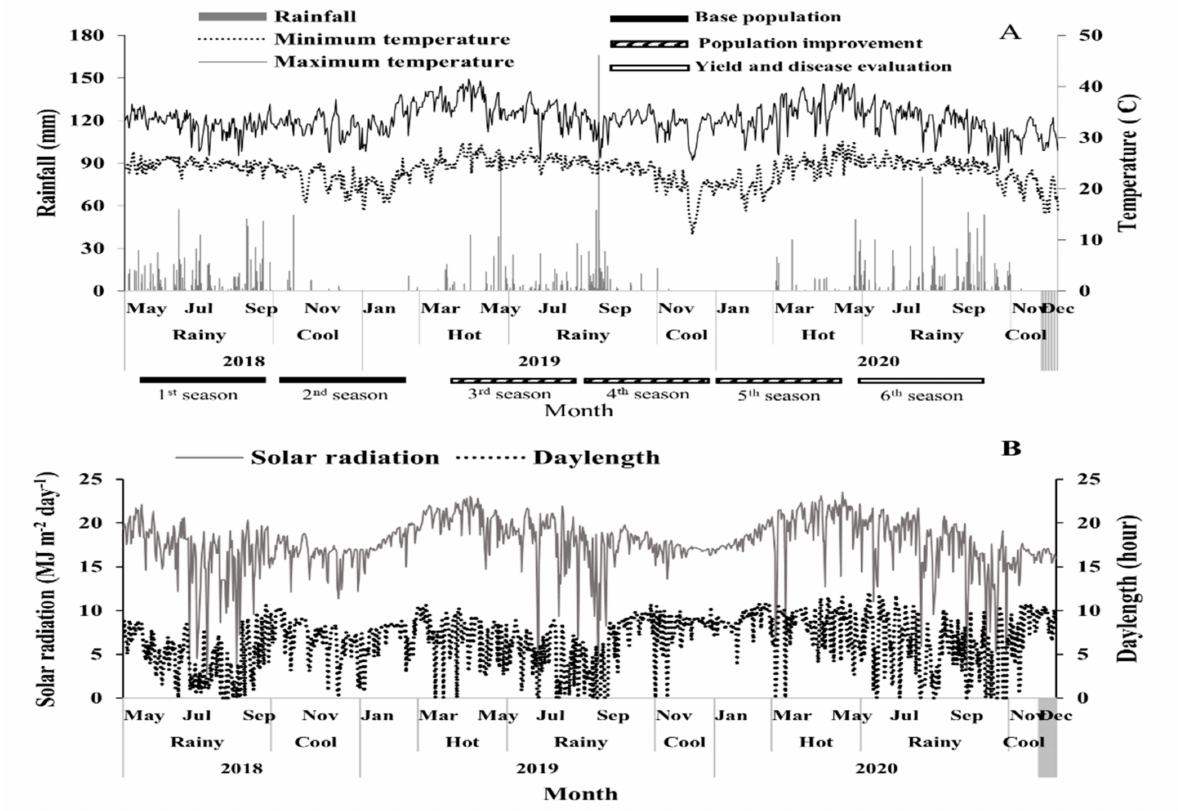
Figure 2. Daily rainfall, maximum and minimum temperatures ( A ), solar radiation and daylength ( B ) for population improvement and trial in the Khon–Kaen province, Thailand,